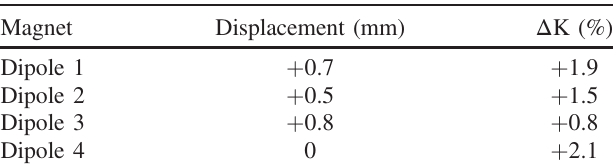
TABLE V. Adjustments made to the position of the dipole magnets and the gradient (magnet current) following beam based